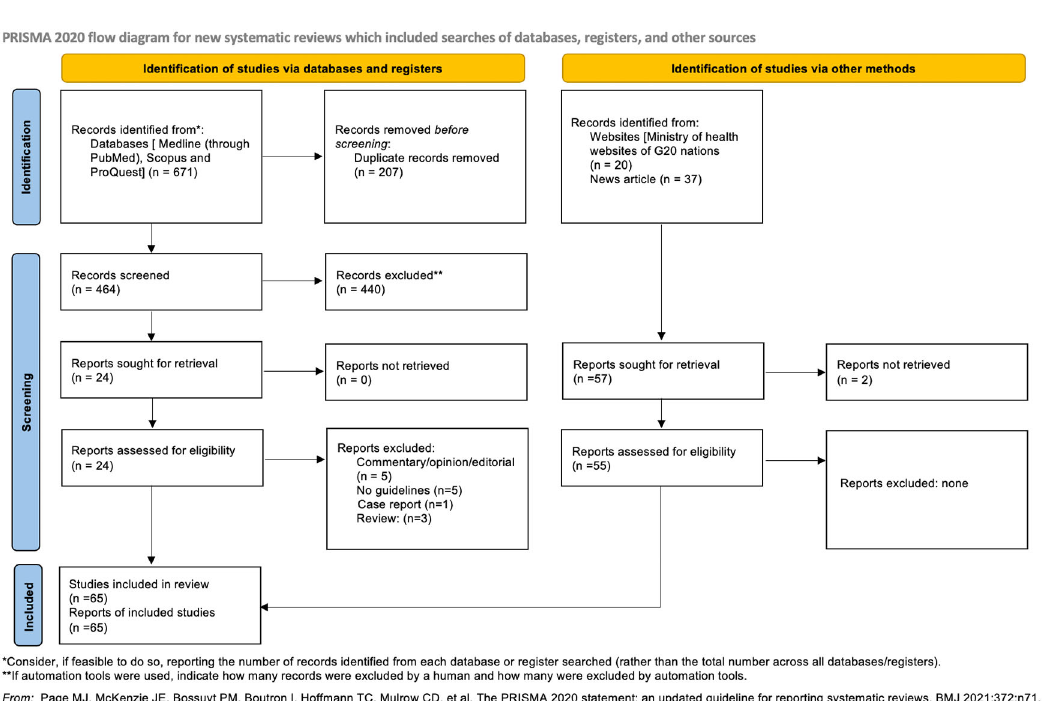
Figure 1. PRISMA